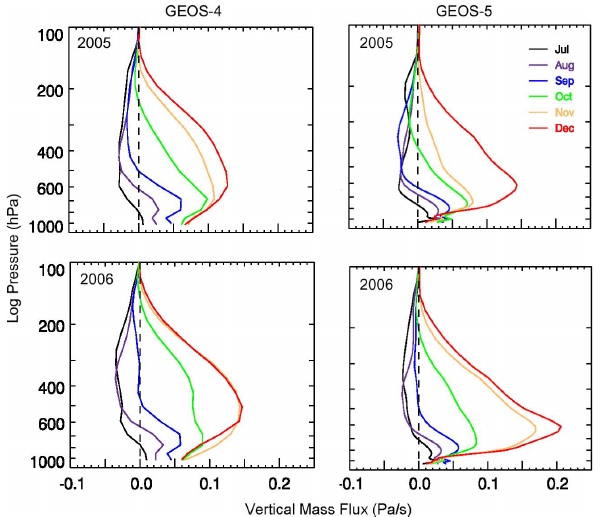
Fig. 20. Time series of TES CO (681 and 422hPa) and MLS CO (215 and 147hPa, scaled as in Fig. 8) (black) with (left) GEOS- 4, (right) GEOS-5 model results over southern Africa. The standard simulation is in red, and the simulation with adjusted emissions (see text) is in